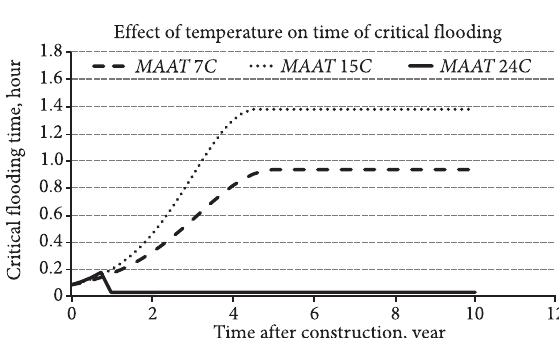
Fig. 4. Effects of retained strength and MAAT on T c,s